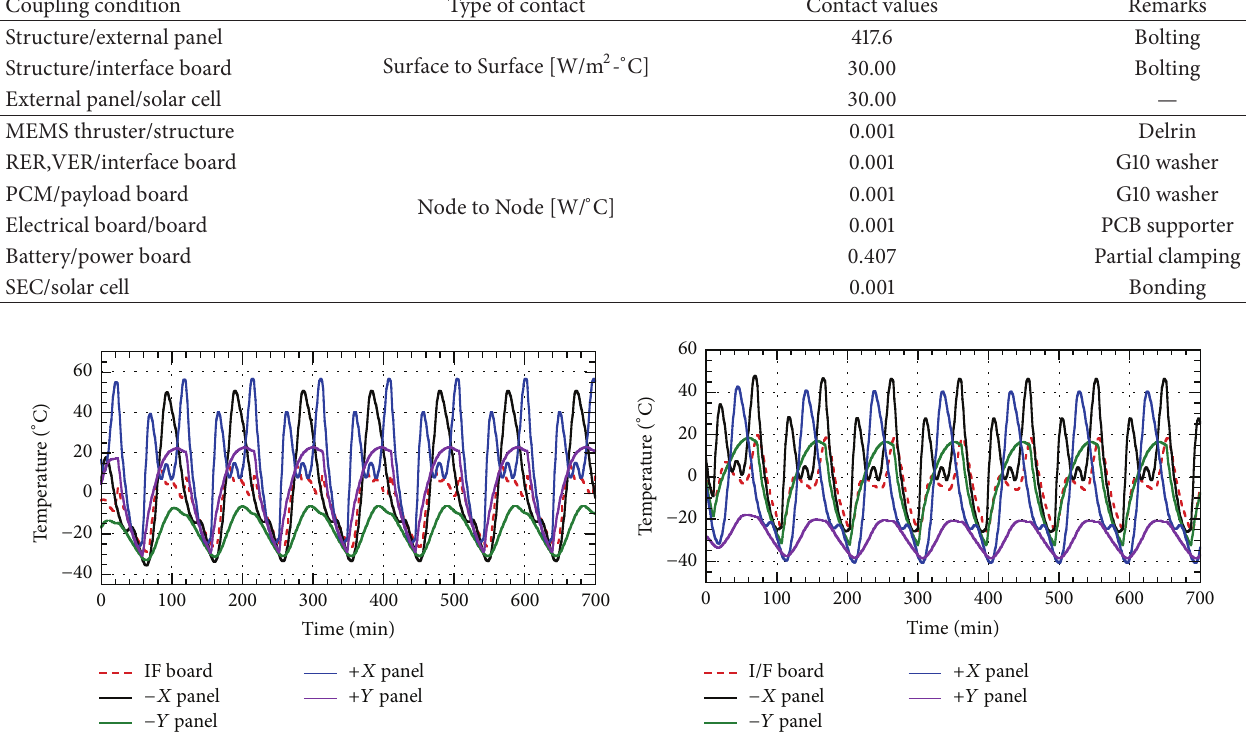
Table 7: Summary of conductor values used in the analysis.